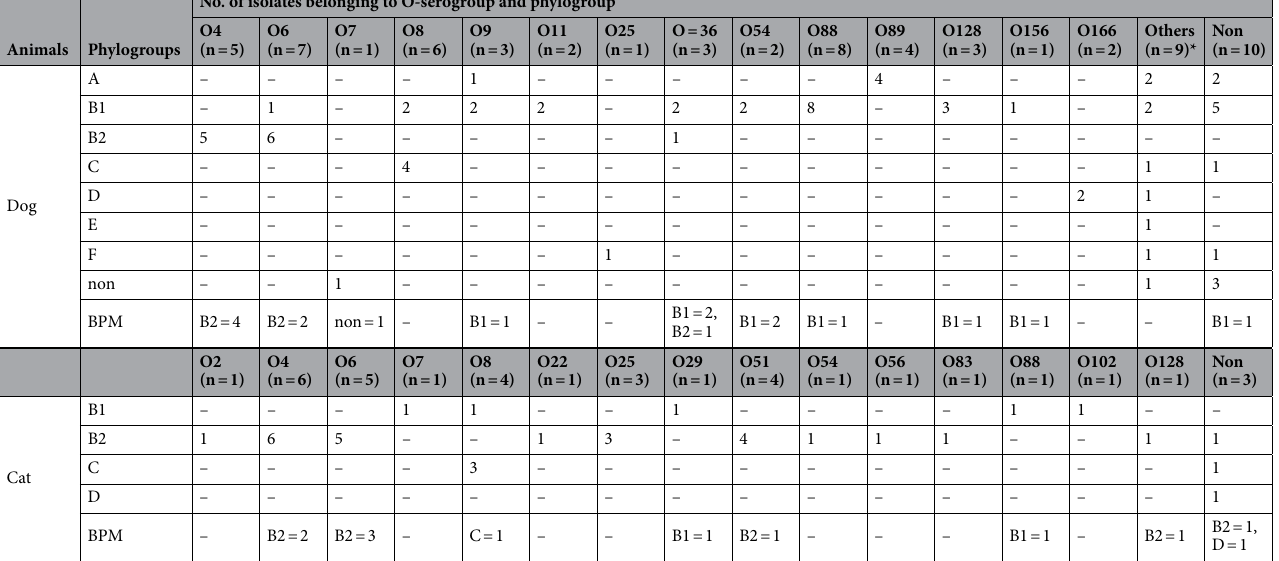
Table 5. Phylogroups and O-serogroups in extraintestinal pathogenic E. coli isolates from the lung samples of dogs and cats. Non non-typeable, BPM bacterial pneumonia-induced